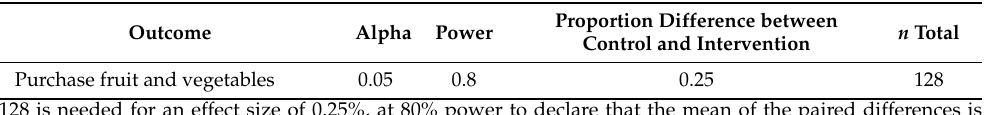
Table 1. Sample Size Power Calculation.